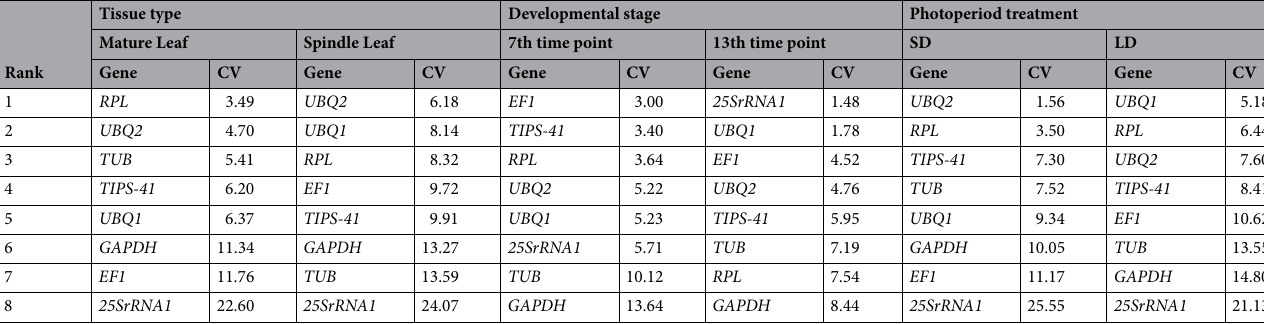
Table 2. Coefficient of variation (CV) according to BestKeeper algorithm, for tissue type, developmental stage (7th and 13th time points) and photoperiod treatment. SD short day; LD long